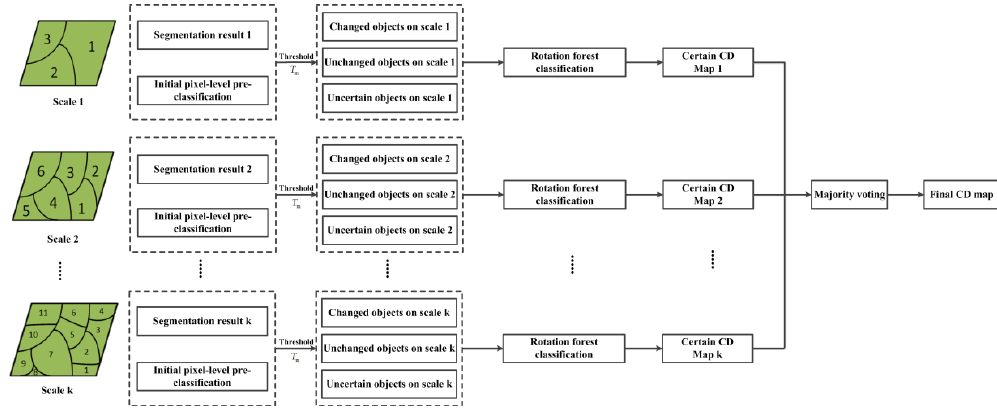
Figure 5. OBCD process incorporating rotation forest and coarse-to-fine uncertainty analyses.